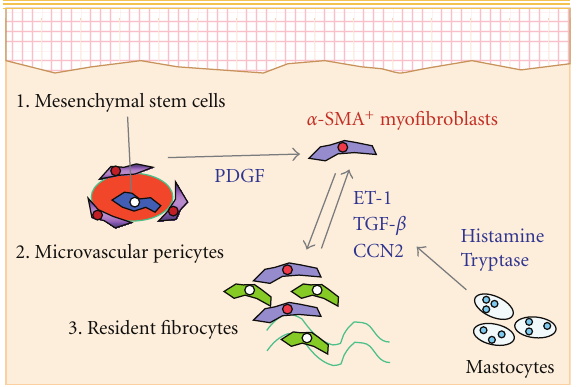
Figure 1: Schematic model of myofibroblast di ff erentiation in the skin. The local myofibroblasts characteristic for α -SMA expression are originated from multiple cell sources in the skin and nominated from at least 3 distinct cell sources: BM-derived mesenchymal stem cells, microvascular pericytes, and resident fibroblasts in the donor skin graft and/or in the perilesional host skin. Some molecules can organise the cell-type-specific di ff erentiation into dermal